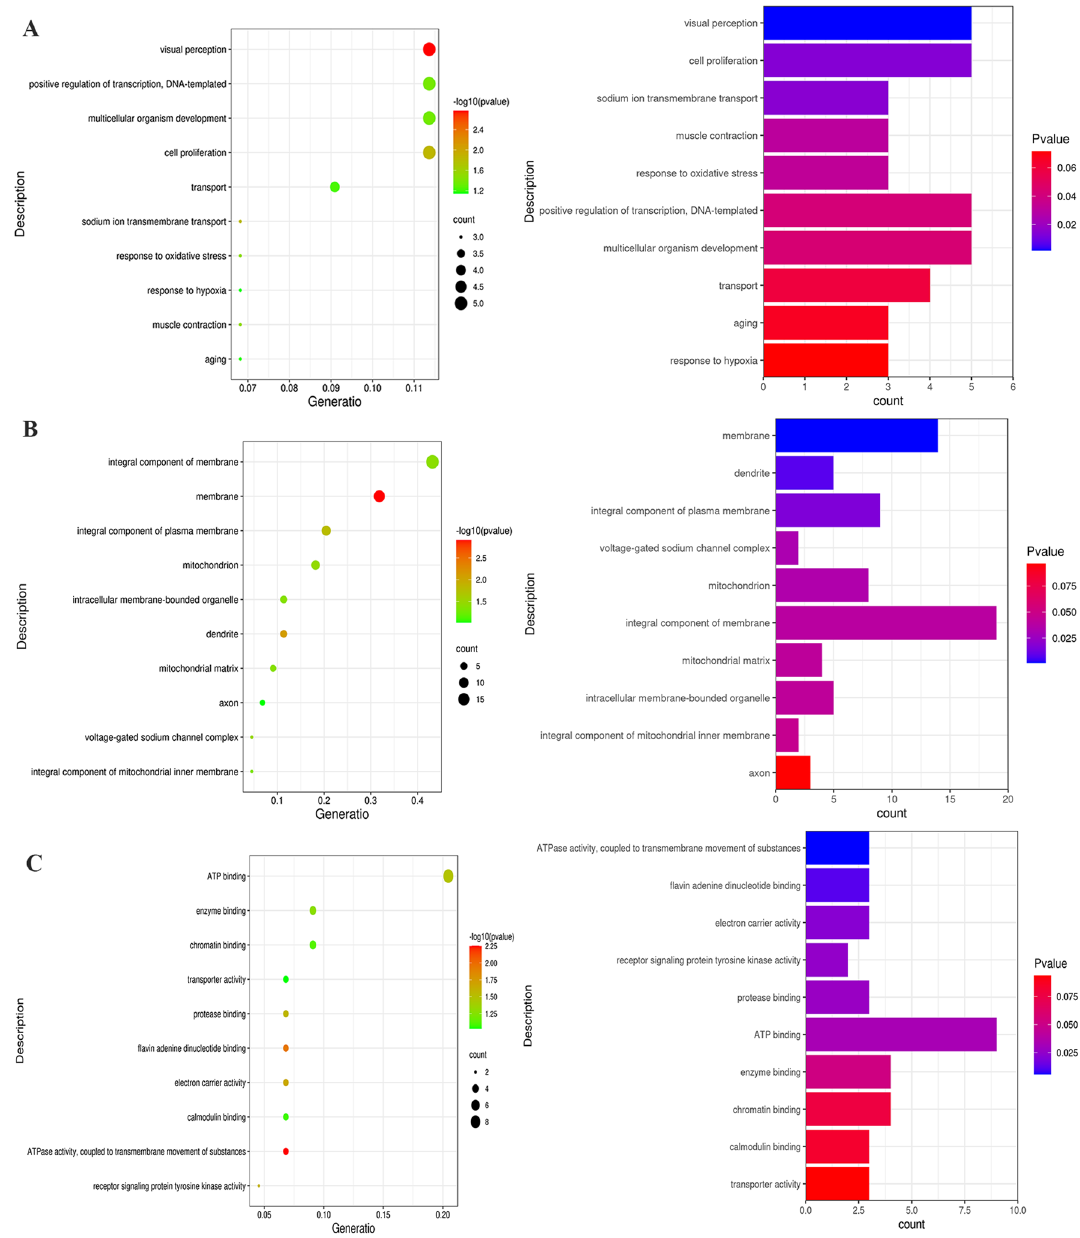
Figure 2. TOP 10 in Go enrichment analysis ( A ). Biological process (GO-BP) of 53 driver genes ( B ). Cellular component (GO-CC) of driver genes ( C ). Molecular function (GO-MF) of driver